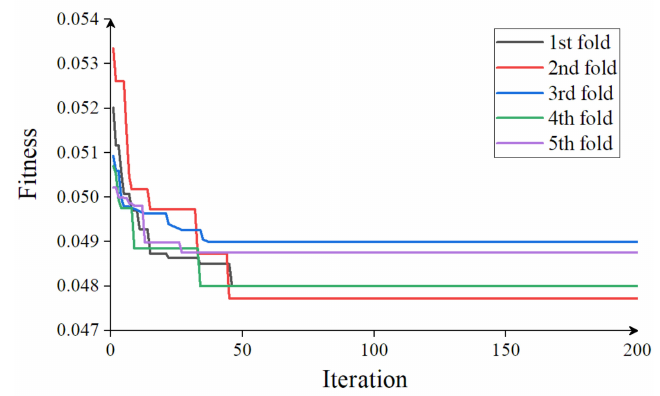
Figure 4. The convergence curves for the five-fold cross-validation.